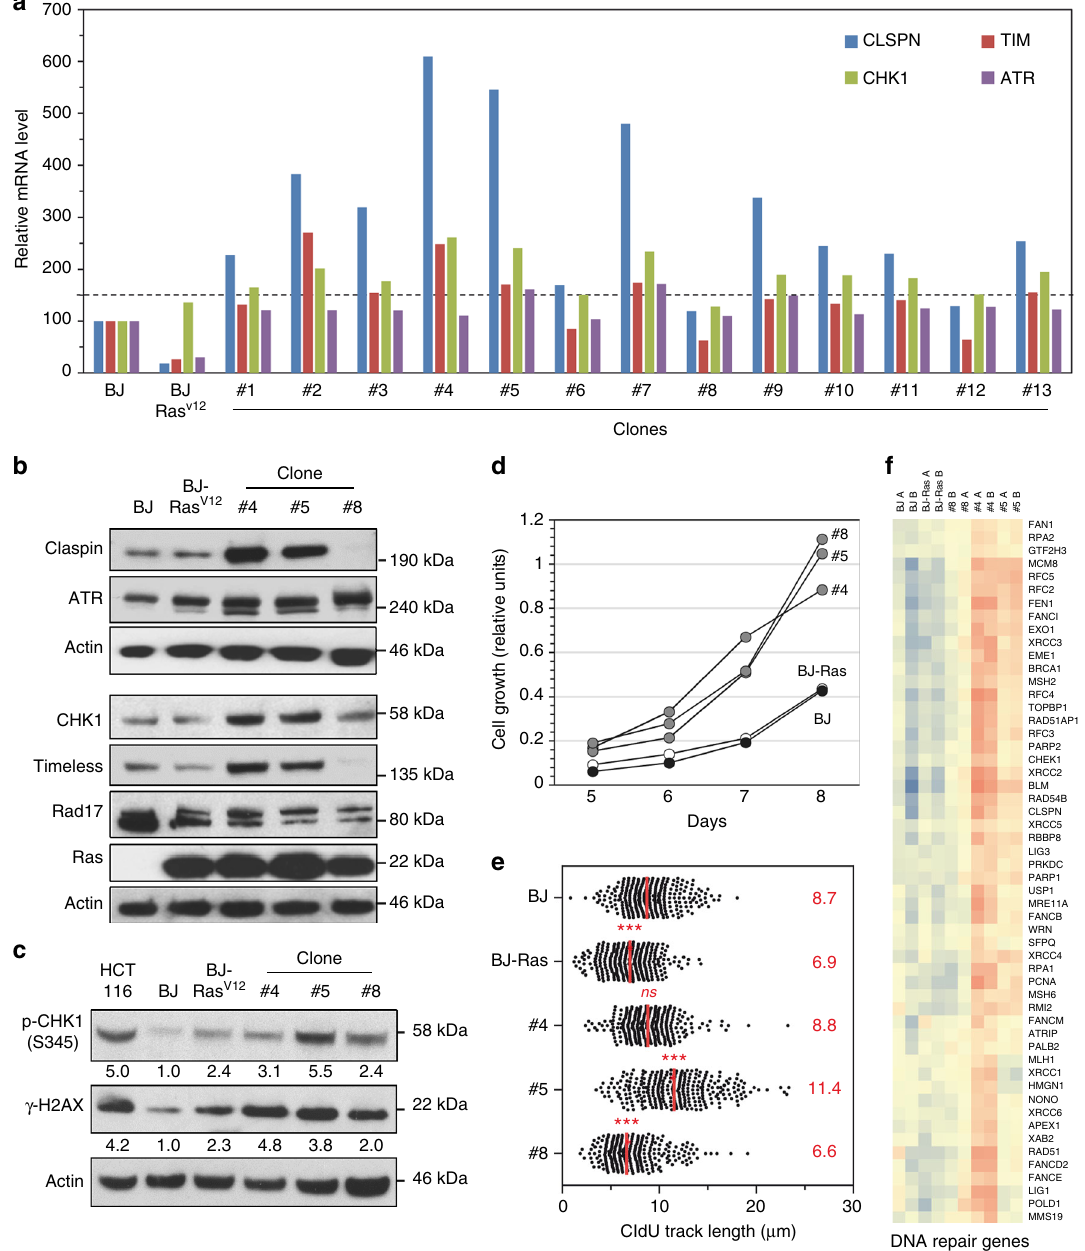
Fig. 5 Primary fi broblasts adapt to oncogene-induced replication stress by overexpressing Claspin and Timeless. a Immortalized BJ-hTERT cells expressing an oncogenic version of Ras (Ras v12 ) under the control of a doxycyclin-inducible promoter were grown for 60 days in the presence of Dox to induce oncogene-induced senescence (OIS). Thirteen individual clones escaping senescence were isolated. The expression of Claspin, Timeless, CHK1, and ATR mRNAs was determined by qRT-PCR in these clones and in BJ-hTERT cells expressing or not Ras V12 after normalization of mRNA levels to HPRT and 18S. BJ-hTERT and BJ-Ras V12 cells were grown in presence of doxycyclin 8 days before analysis. b Western blot analysis of Claspin, Timeless, CHK1, ATR, RAD17 protein levels in BJ-hTERT, BJ-Ras v12 cells, and in clones #4, #5, and #8. c Western blot analysis of phospho-CHK1 (S345) and γ -H2AX in BJ-hTERT and BJ-Ras v12 cells and in clones #4, #5, and #8. d DNA fi ber spreading analysis of fork progression in these cells after 10 min IdU and 20 min CldU pulses. The median length of CldU tracks (red) was determined for fi ve independent experiments. **** p < 0.0001, *** p < 0.001, ns nonsigni fi cant difference with BJ cells. Mann – Whitney rank sum test. e Growth of BJ-hTERT (black), BJ-Ras v12 (white) after 8 days in the presence of doxycyclin and clones #4, #5, and #8 (gray). f Hierarchical clustering analysis of BJ-hTERT, BJ-Ras v12 , and clones #4, #5, and #8 based on the expression of DNA repair genes (in two independent experiments: A and B). Blue: low expression, red: high expression higher in cancer cell lines relative to immortalized fi broblasts, downstream components of the ATR-CHK1 pathway de fi ne a which is consistent with earlier studies 63,64 . Moreover, we functional module that is speci fi cally enhanced in cancer cells. observed a tight correlation between the abundance of Claspin, Importantly, we also found that in low-grade NSCLC, Timeless, and CHK1 proteins the proteomic landscape of 50 increased expression of Claspin, Timeless, and CHK1 (but not colon cancer cell lines 43 . Together, these data indicate that the ATR, RAD9, and RAD17), correlates with the aggressiveness of NATURE COMMUNICATIONS| (2019) 10:910